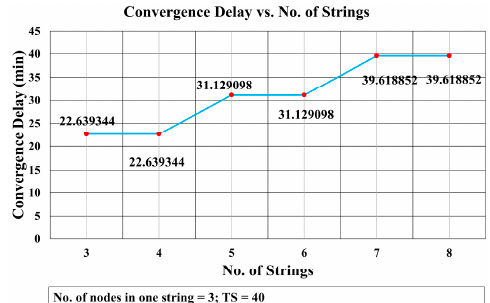
Figure 13. Convergence Delay vs. No. of Strings.